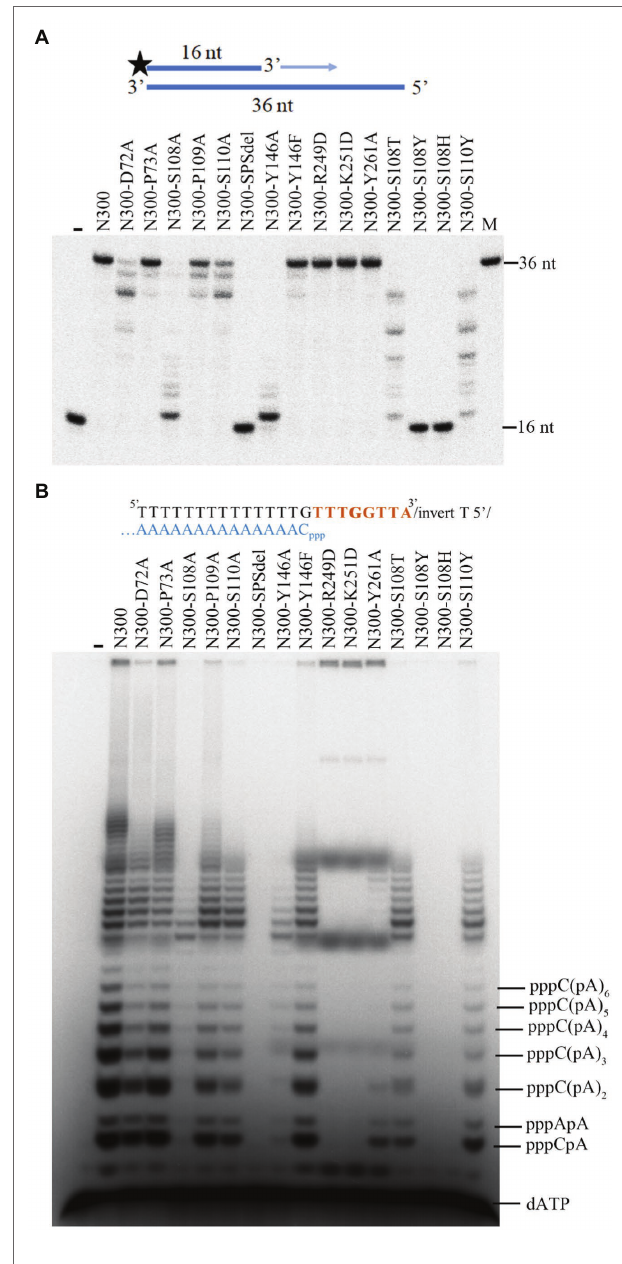
FIGURE 2 | The DNA polymerase and primase activities of N300 and its mutants. (A) Extension of 32 P-labeled 16/36-mer primer/template duplex substrate by N300 and its mutants. The reactions were incubated for 20 min at 50 ° C, and the products were separated on a 7 M urea-10% PAGE. (B) Primer synthesis on a designed 23-nt DNA template by N300 and its mutants as described previously (Zhu et al., 2017). The reactions were incubated for 30 min at 50 ° C, and the products were separated on a 3 M urea-25% PAGE. Data in the figure are representative of at least two independent